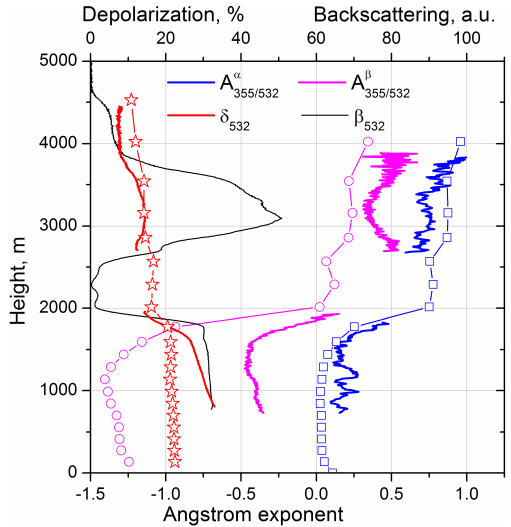
Figure 16. Extinction ( A α ) and backscattering ( A β ) 355 / 532 355 / 532 Ångström exponents together with the particle depolarization ratio δ 532 obtained from lidar measurements (line) and from MERRA-2 modeling (line + symbols). Lidar data are averaged over the 19:00– 23:00UTC period while model data are given for 21:00UTC.